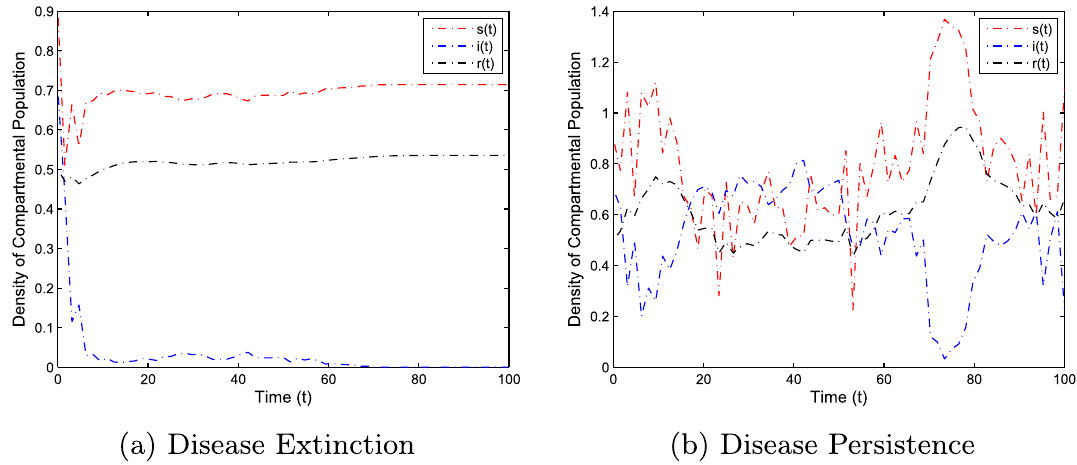
Figure 5. The graphs demonstrate the extinction and persistence analysis of the SARS-CoV-2 virus transmission using the proposed model